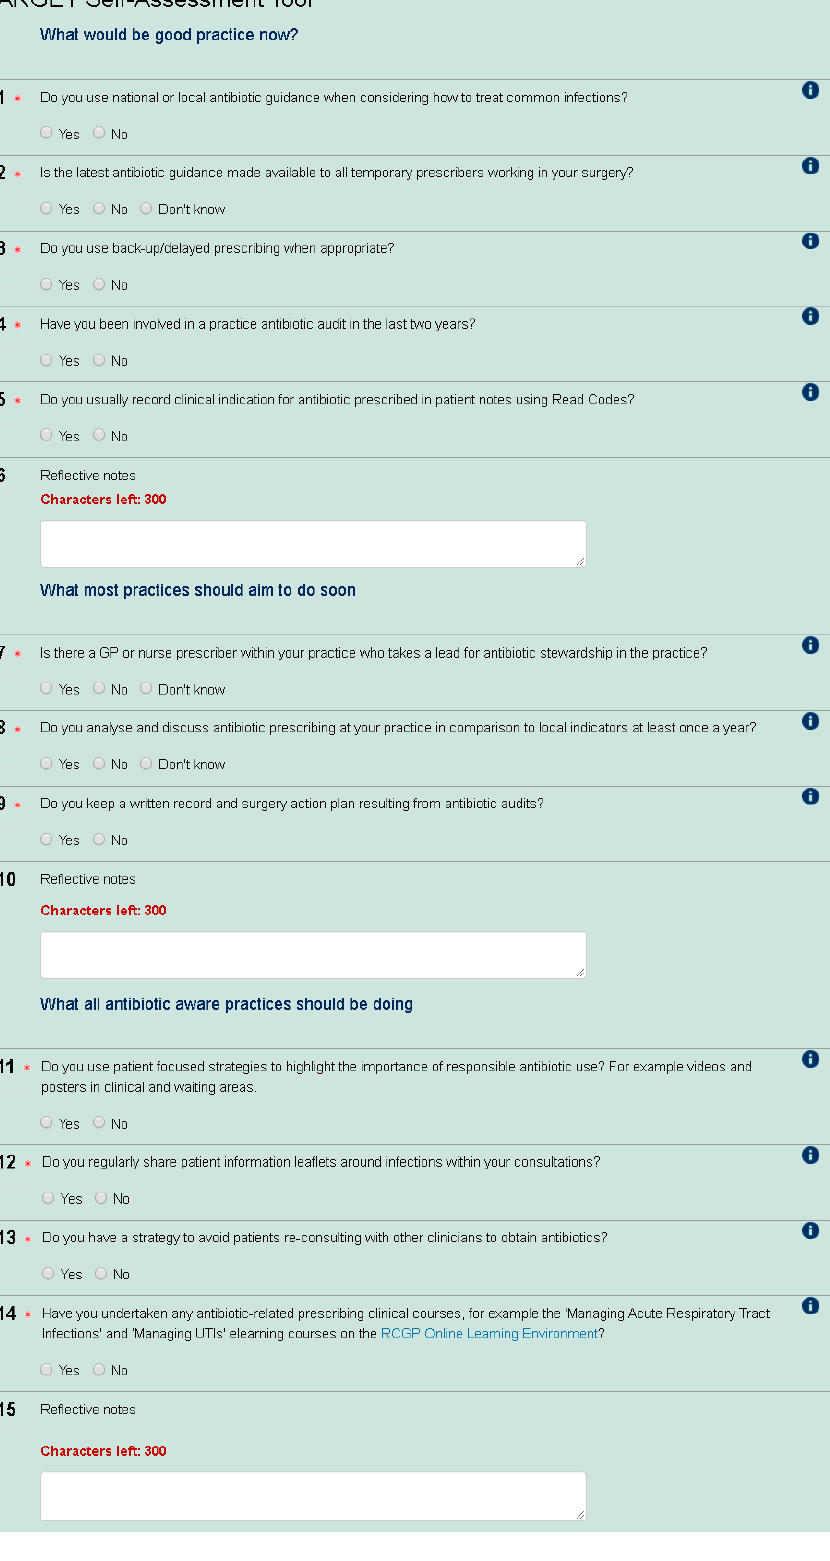
Figure 1. The primary care self-assessment tool.